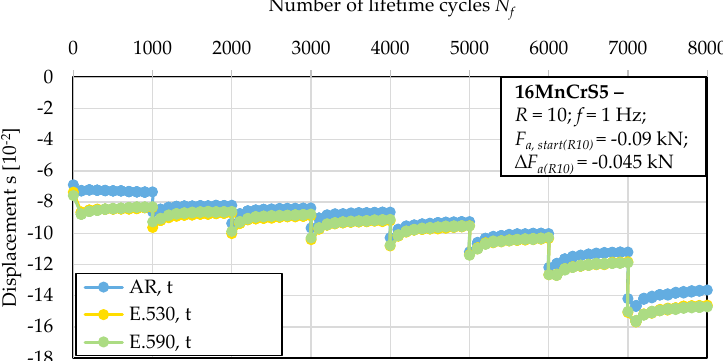
Figure 6. Material reaction under cyclic compression load conditions obtained transversal to the extrusion direction (t) after the load increase test (LIT).